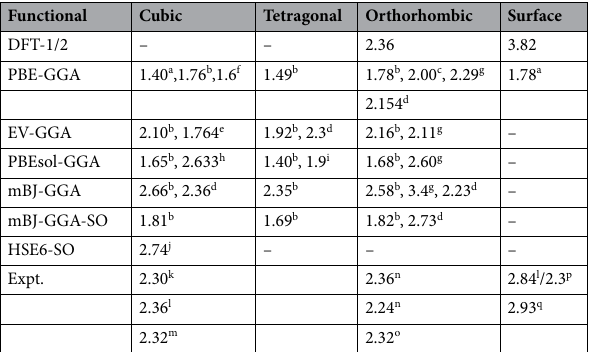
Table 2. Result of electronic bandgap (E g ) in eV of bulk and surface of CsPbBr 3 from DFT-1/2 and comparison with the results of other functional. a 43 , b45,46 , c56 , d33 , e64 , f65 , g66 , h67 , i68 , j57 , k69 , l70 , m71 , n60 , o72 , p73 , q59 .